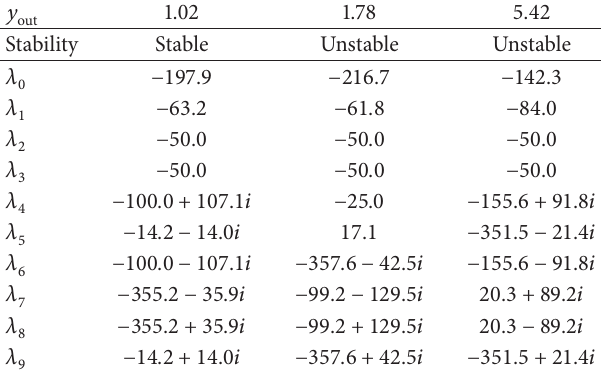
Table 4: Eigenvalues for Phase 2, 𝐵 = 38 .